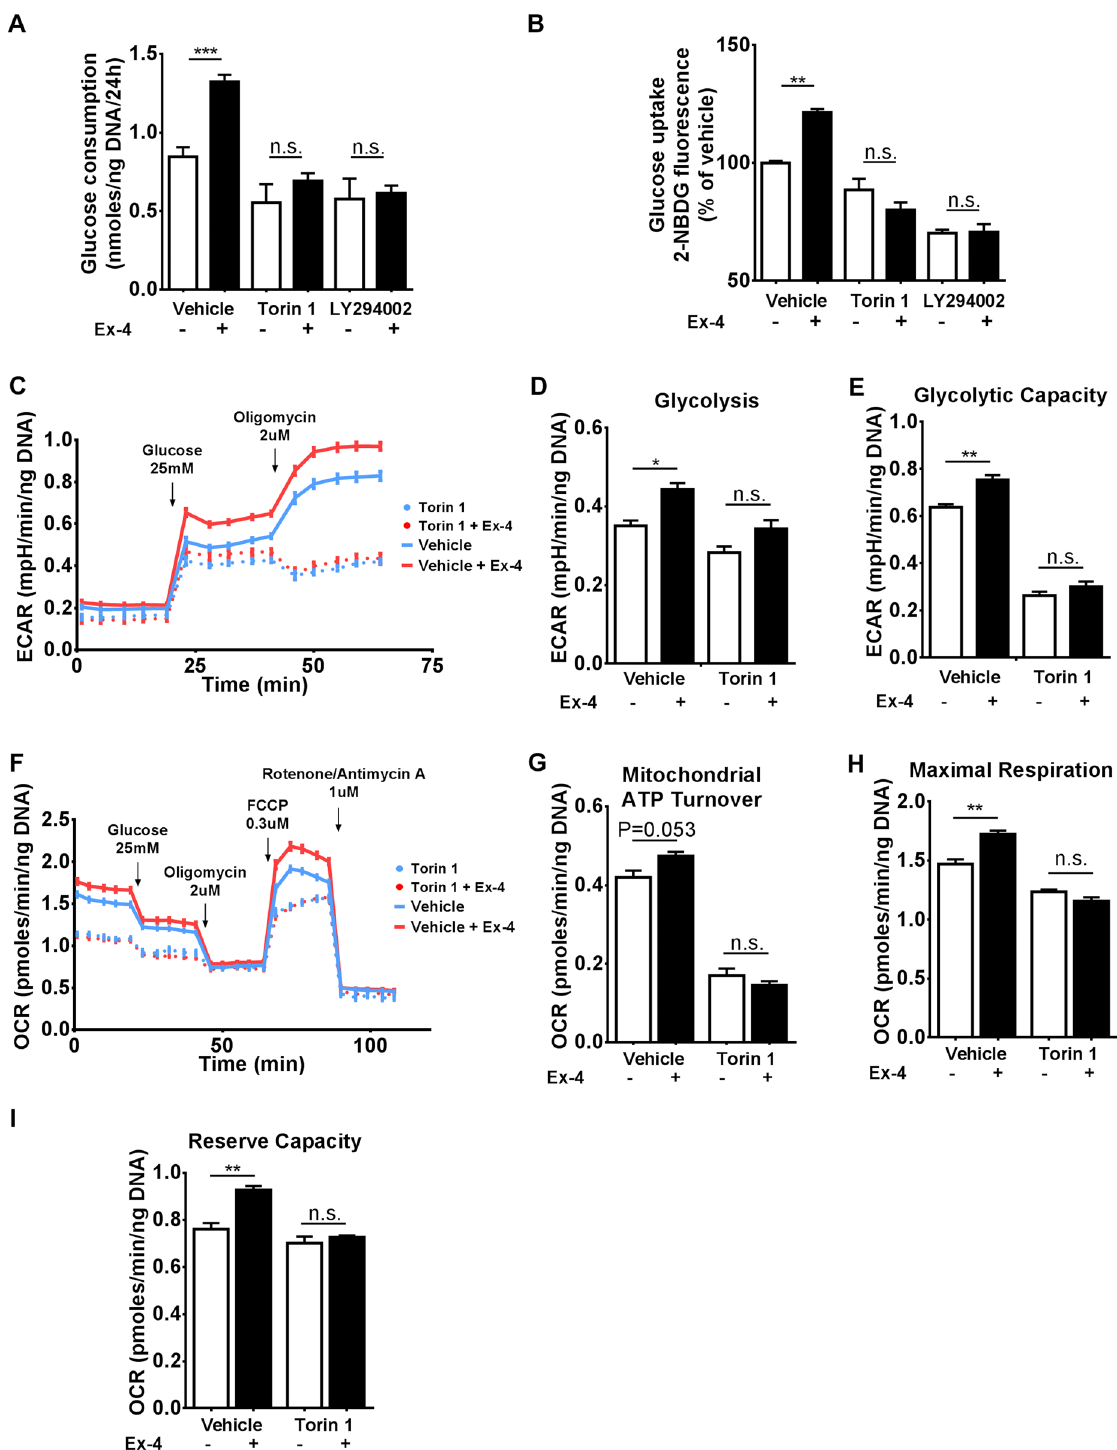
Figure 5. Inhibition of the PI3K/mTOR axis abolishes the effects of GLP-1R signalling on cellular metabolism. ( A ) BRIN-BD11 cells were pre-incubated with either vehicle, 1 µ M Torin 1, or 50 µ M LY294002 for 30 min, followed by addition (or not) of 50 nM Exendin-4 for 18 hours, as indicated. Then, media was changed to RPMI containing 20 mM of glucose for additional 24 hours in the absence of Exendin-4 and glucose consumption was determined. ( B – I ) Cells were treated similarly to ( A ), but instead of the additional 24 hours incubation time, 2-NBDG uptake or extracellular flux analysis were performed immediately following the 18 hours incubation period and parameters calculated as described in Methods. Data represent mean ± SEM, n ≥ 3; n.s. = non- significant; * P < 0.05; ** P < 0.01; *** P <